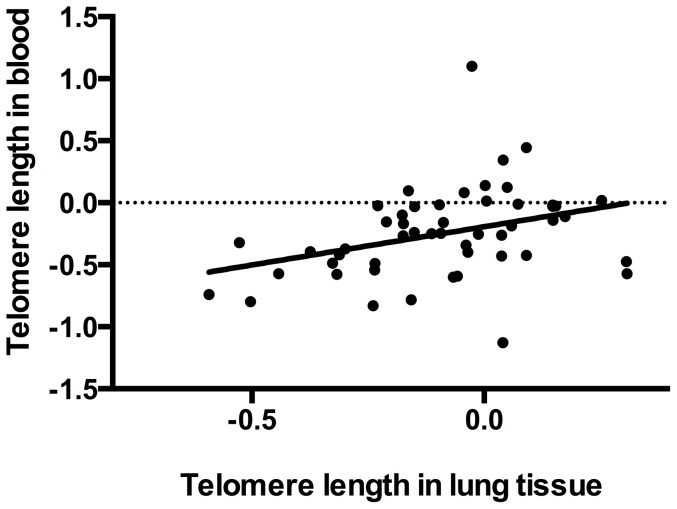
Log10 of telomere length in the lung vs. log10 of telomere length in the blood.